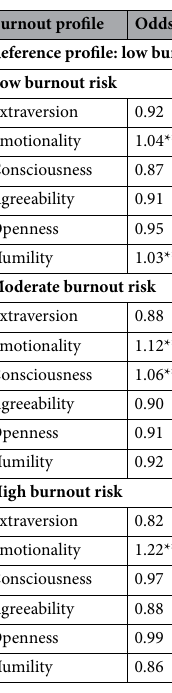
Table 4. Effects of predictors on membership in latent profiles of teacher burnout risk. Odds ratios (OR), 95% confidence interval for the effects of the six personality factors on teacher burnout profile membership. LL lower limit of the confidence interval, UL upper limit. **p < 0.01; ***p <